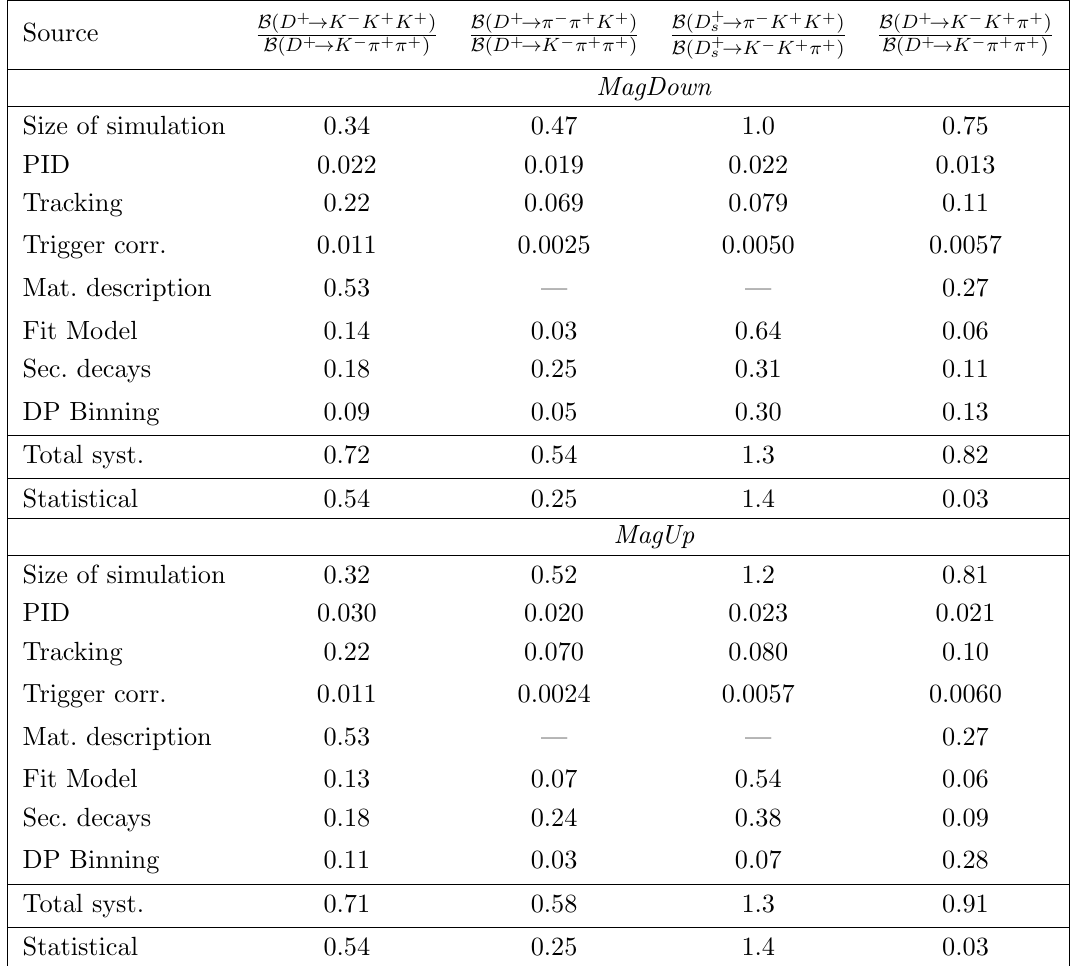
Table 5 . Relative systematic uncertainties for the MagDown and MagUp results (in %). The statistical uncertainties are also given for